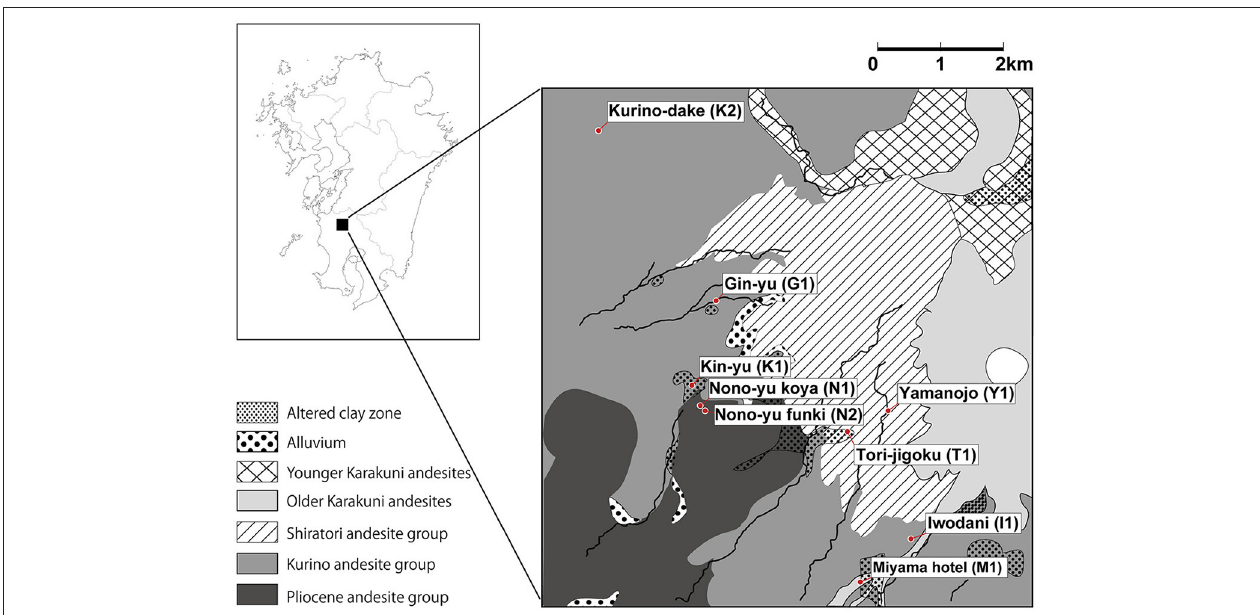
FIGURE 1 | Geological map of the Kirishima area showing locations of the sampling sites for metagenomic